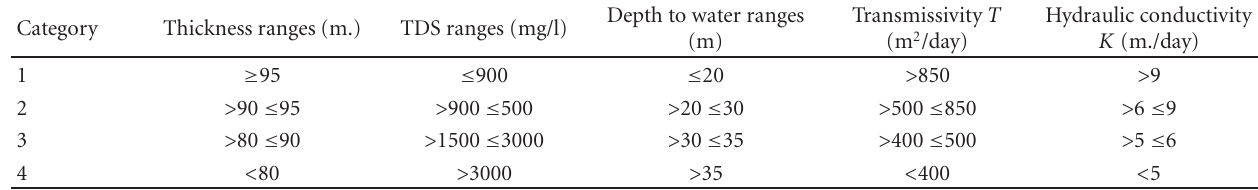
Table 4: The thickness, TDS, depth to water, transmissivity, and hydraulic conductivity category ranges for the saturated layer (B2). Category Thickness ranges (m.) TDS ranges (mg/l)